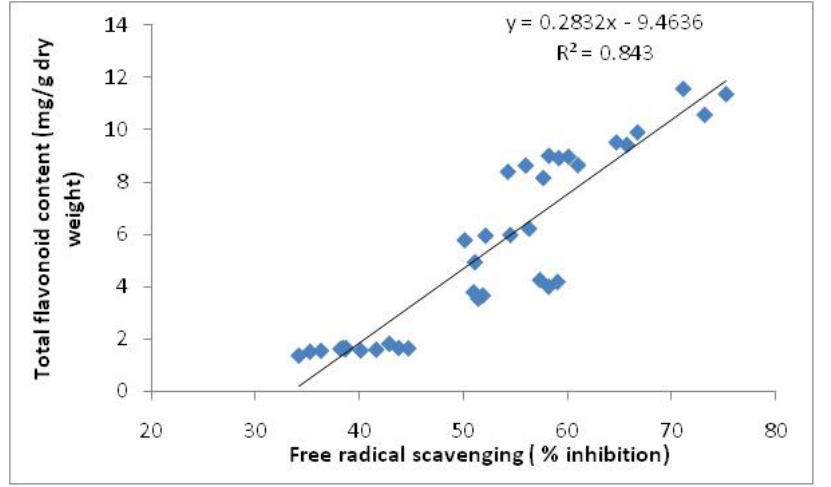
Figure 4. Relationship between total flavonoids and total antioxidant activities of Zingiber officinale